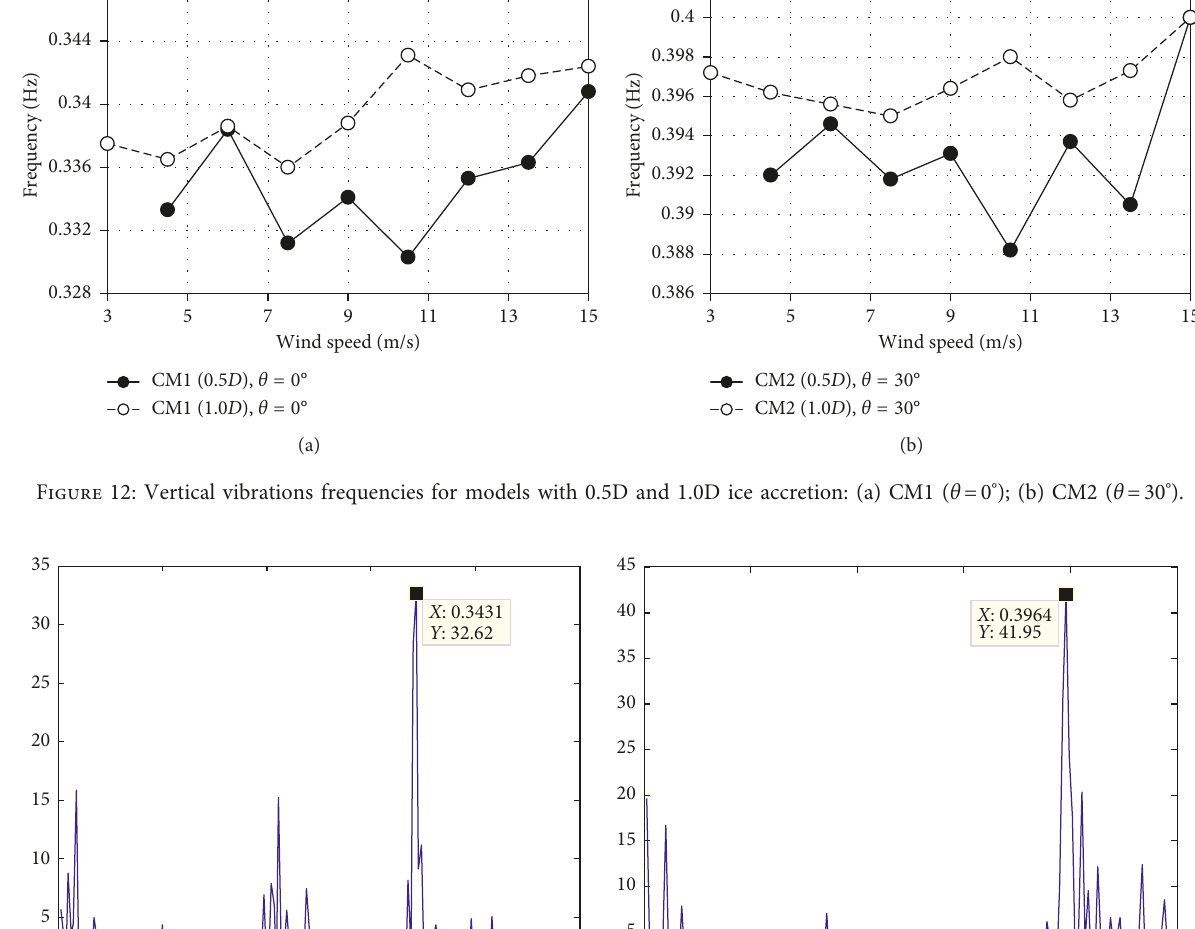
0 Figure 13: FFTdistribution of frequencies for models with an ice thickness of 1.0D at 10.5m/s for (a) CM1 ( θ � 0 ° ) and (b) CM2 ( θ � 30 °